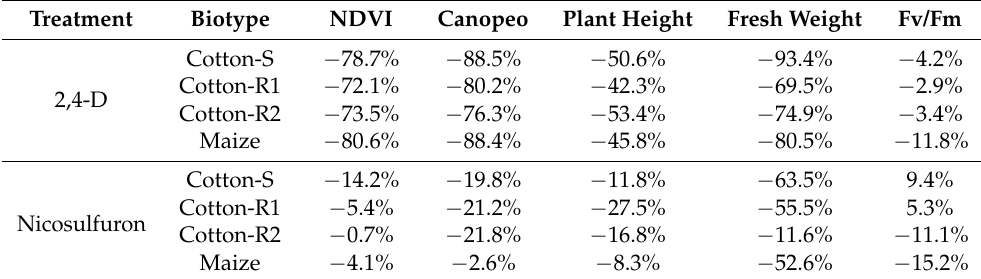
Table 3. NDVI, Canopeo, plant height, fresh weight per plant and Fv/Fm values for all the studied A. palmeri biotypes and the treatments 2,4-D and nicosulfuron compared to the untreated control for each